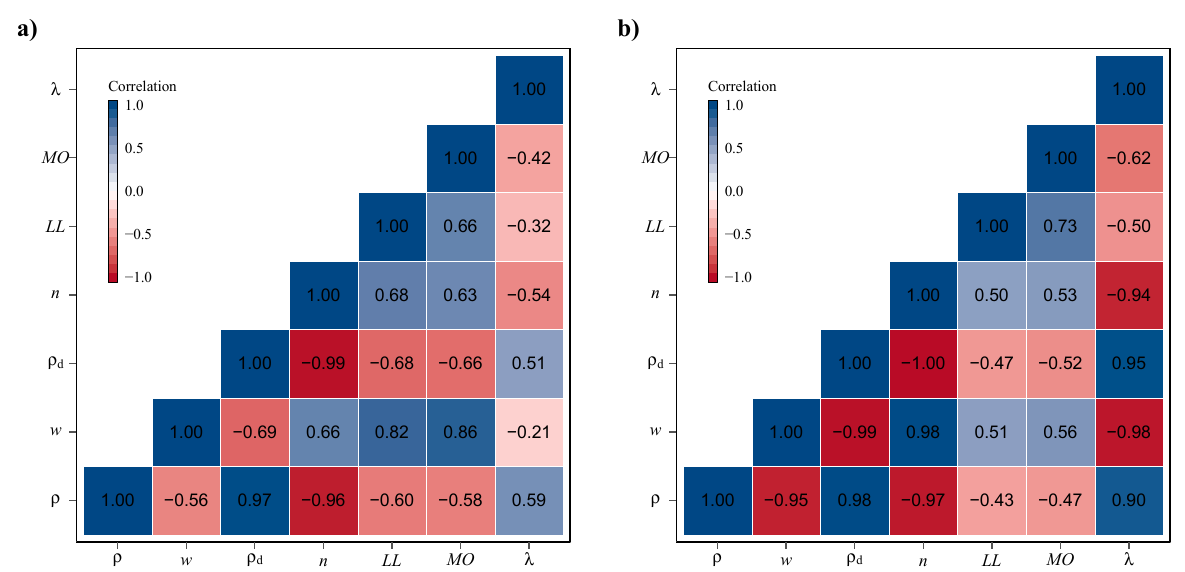
Figure 7. Correlation matrix of index and thermal properties: ( a ) coarse-grained; and ( b ) fine-grained soils. Note: ρ = total density, w = water content, ρ d = dry density, n = porosity, LL = liquid limit, OM = organic matter, λ = thermal conductivity.